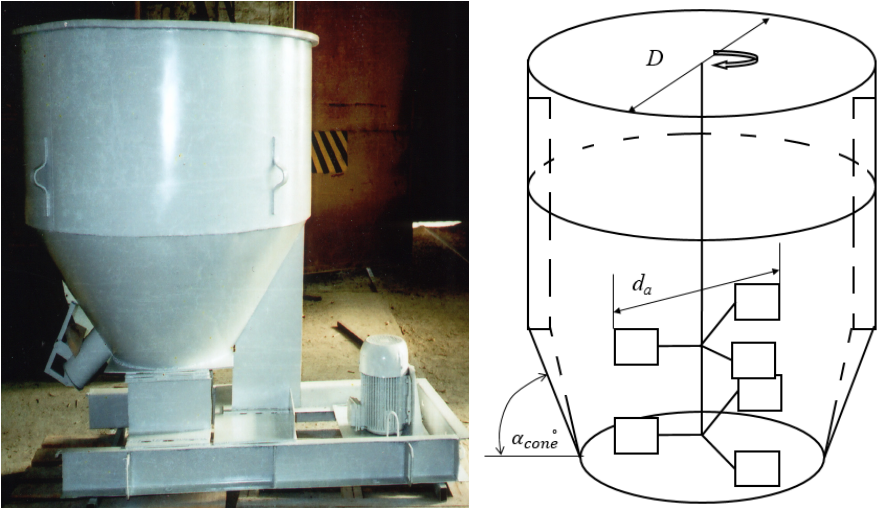
Figure 3. Cylindrical mixer with conical part.